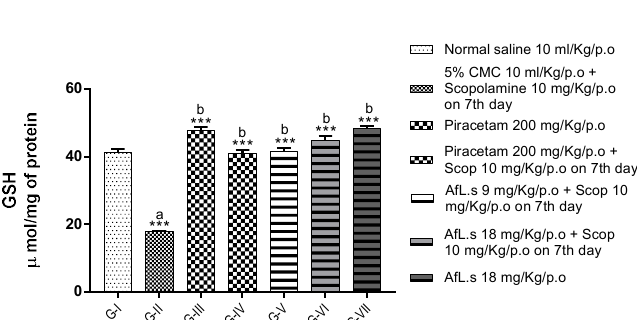
Figure 3. Effect of AfL.s on concentration of ( A ) acetylcholinesterase (AChE); ( B ) MDA; ( C ) SOD; ( D ) CAT; and ( E ) GSH in brain homogenate. Data are presented as mean ± SEM ( n = 6) and one-way ANOVA (Dunnett’s test) was applied by comparing G-II to G-I (presented by “a” on bar). All other groups were compared to G-II (presented by “b” on bar). The signs ns , *, ** and *** presented the p values as ≥0.05, ≤0.05, ≤0.01, and ≤0.001, respectively).